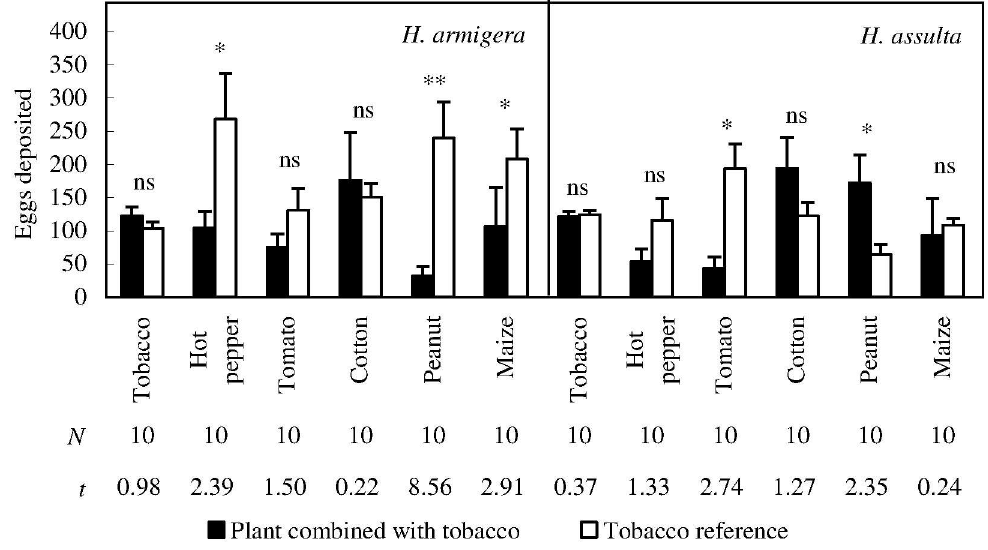
Fig 4. Ovipositional choice responses of H . armigera and H . assulta mated females under the conditions of each plant species combined with tobacco versus tobacco plant. “ * ” and “ ** ” at the upper panel of the figure indicatesignificantdifference within group at P = 0.05 and P = 0.01 levels, respectively,and “ns” indicates no significantdifference within group, tested by paired t test. The values of “ N ” and “ t ” beneathrespectivebars indicatereplicationsand statistical t values, respectively.